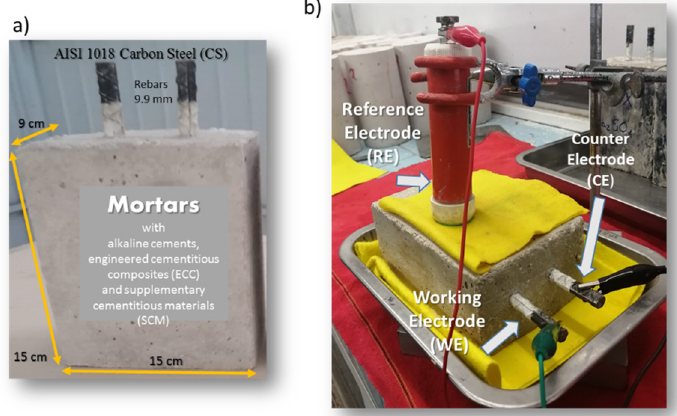
Figure 1. Experimental arrangement. ( a ) Specimens dimensions, ( b ) conventional three-electrode corrosion cell.